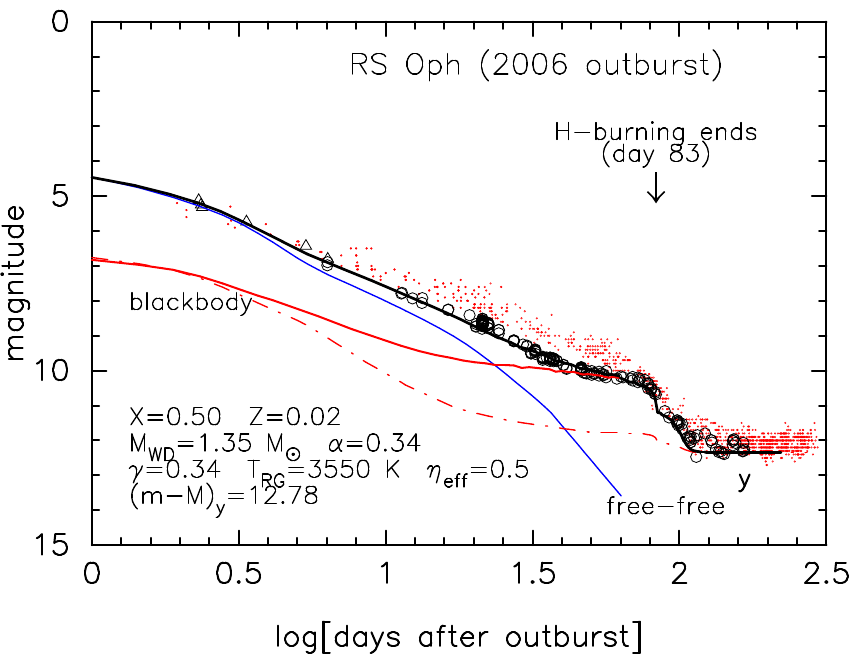
Fig. 2. Calculated light curves of RS Oph taken from Hachisu et al. (2006). The optical light curves are a combination of free-free plus disk irradiation. The plateau phase is reproduced with a relatively large disk, in this case the size of the disk is 34% of the Roche lobe radius and 50% irradiation efficiency ( d = 1 : 3 kpc). Thin solid lines denote the free-free emission brightness (labelled ‘free-free’) or the blackbody emission luminosity (labelled ‘blackbody’) of WD+RG+Disk. Thick solid lines are the total of the free-free plus blackbody. Dash-dotted lines are the blackbody luminosity only from the WD and the RG with irradiation. We cannot reproduce the mid-plateau phase without a disk. The final sharp decline corresponds to the end of the hydrogen shell